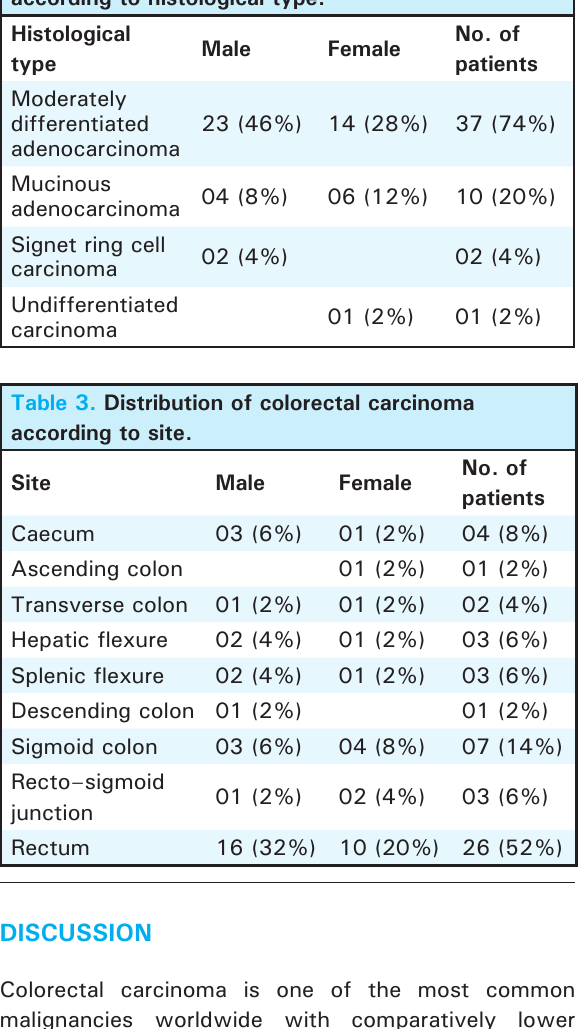
Table 2. Distribution of colorectal carcinoma according to histological type.